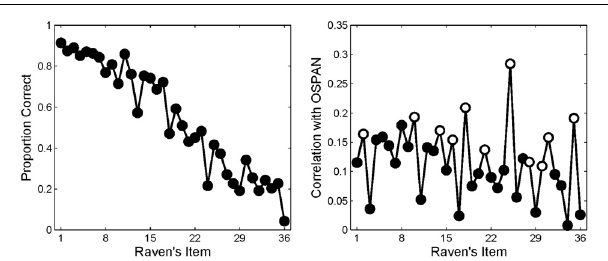
FIGURE 2 | Observed accuracy (left panel) and observed item-wise point bi-serial correlations (right panel) in Wiley et al. (2011). White circles indicate items containing “novel” rule combinations. Right panel adapted from Wiley et al.